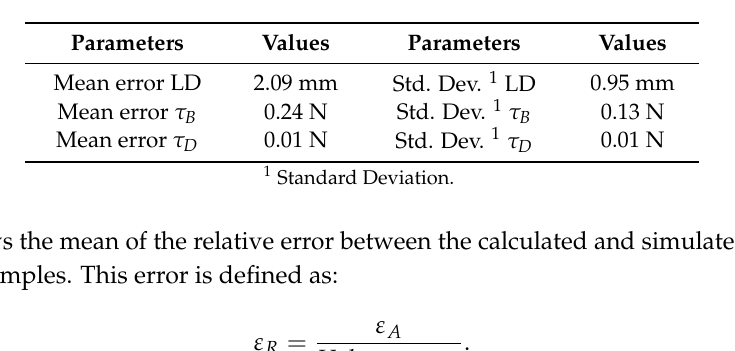
Table 5. Absolute imprecision between model and simulation.